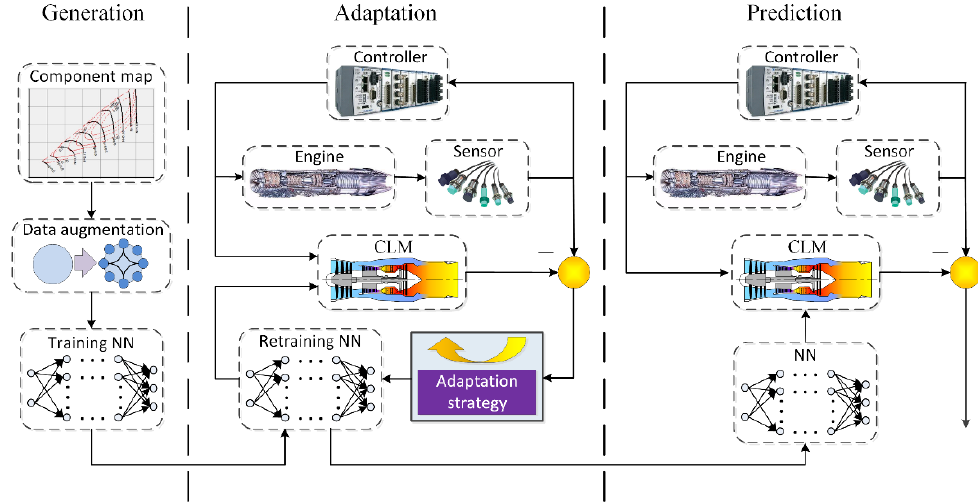
Figure 1. Framework of the proposed performance adaptation method.